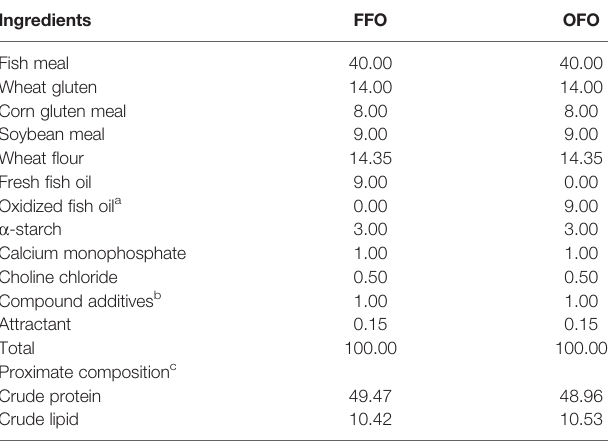
TABLE 1 | Composition and nutrients levels of the test diets (air dry matter